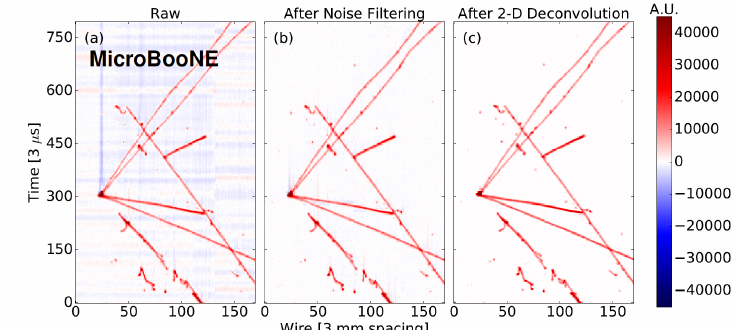
Figure 1. Candidate neutrino interaction event display from MicroBooNE data through each stage of signal processing from raw data ( a ), noise filtering ( b ), and finally the event with both noise filtering and 2D deconovolution ( c ). Figure was taken from [14].